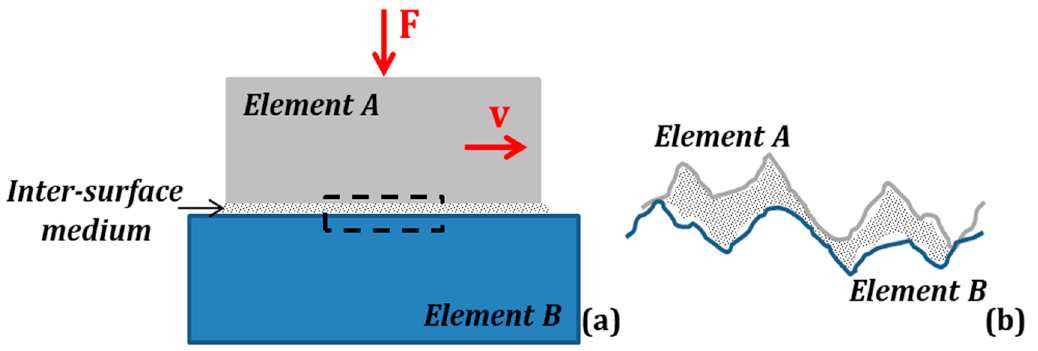
Figure 1. ( a ) Schematic representation of a tribosystem and ( b ) magnification of the inter-surface area marked in ( a ).